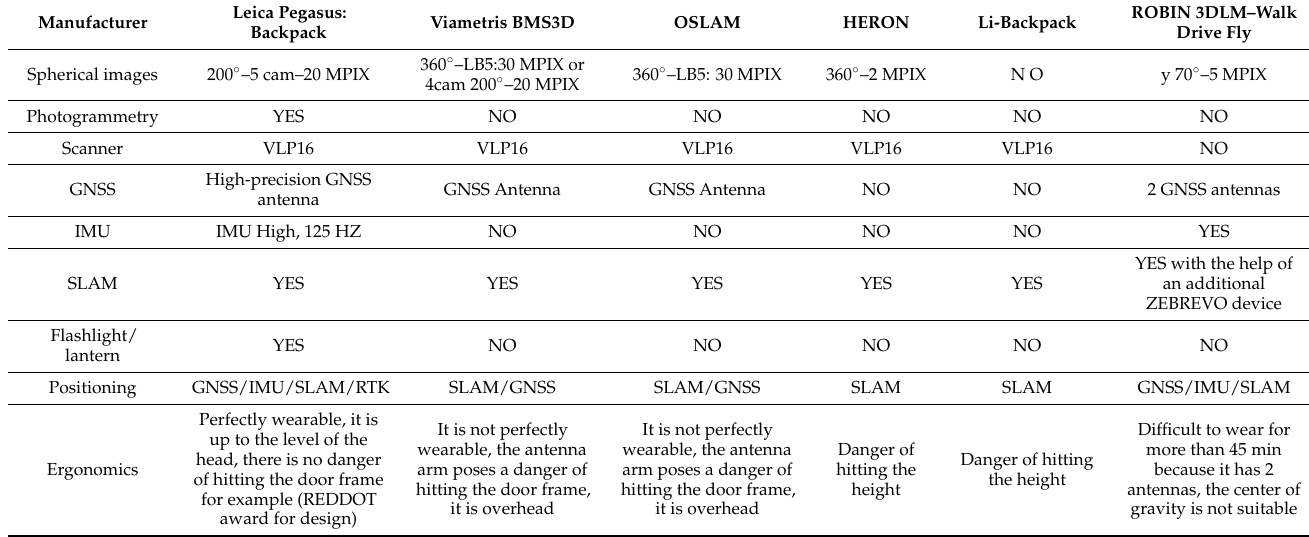
Table 19. Comparative data for several devices using mobile scanning technology.